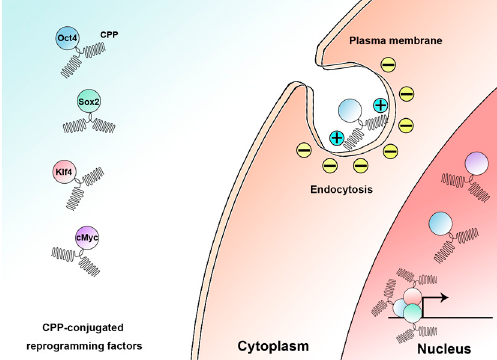
Figure 2. Cellular uptake mechanism of cell-penetrating peptides (CPP)-conjugated proteins. The positively-charged amino acid residues of the CPP interacts with the negatively-charged cell membrane constituents and enables the target protein to be taken up into cytosol via endocytosis. c-Myc: Myc proto-oncogene, bHLH transcription factor; Klf4: Kruppel-like factor 4; Oct4: Octamer-binding transcription factor 4; Sox2: Sex determining region Y-box 2.